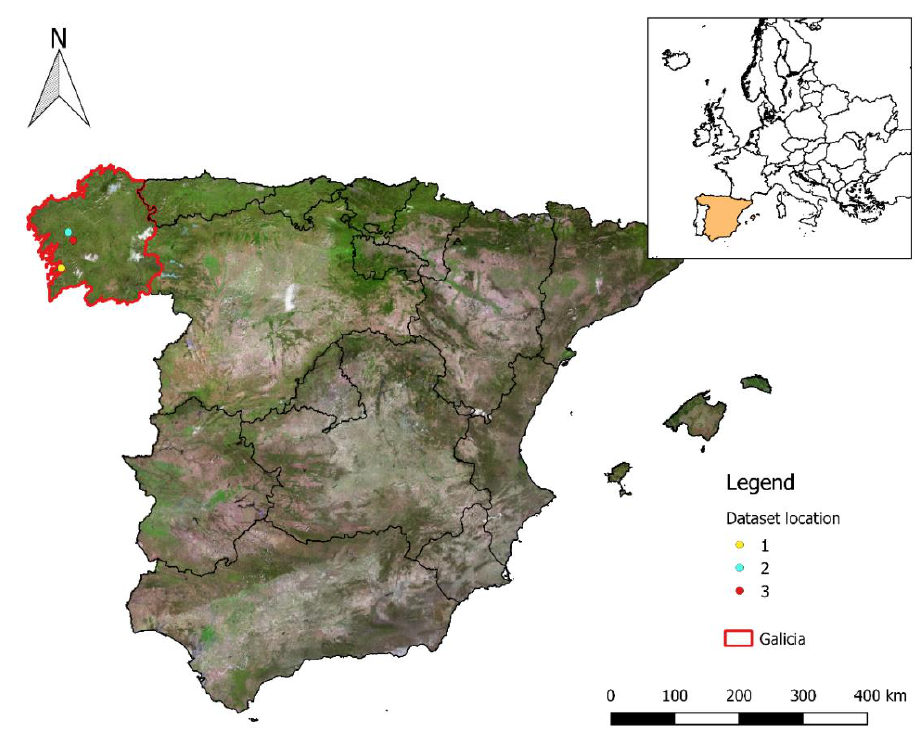
Figure 1. Location of the three datasets in Galicia (red line), Spain. 106